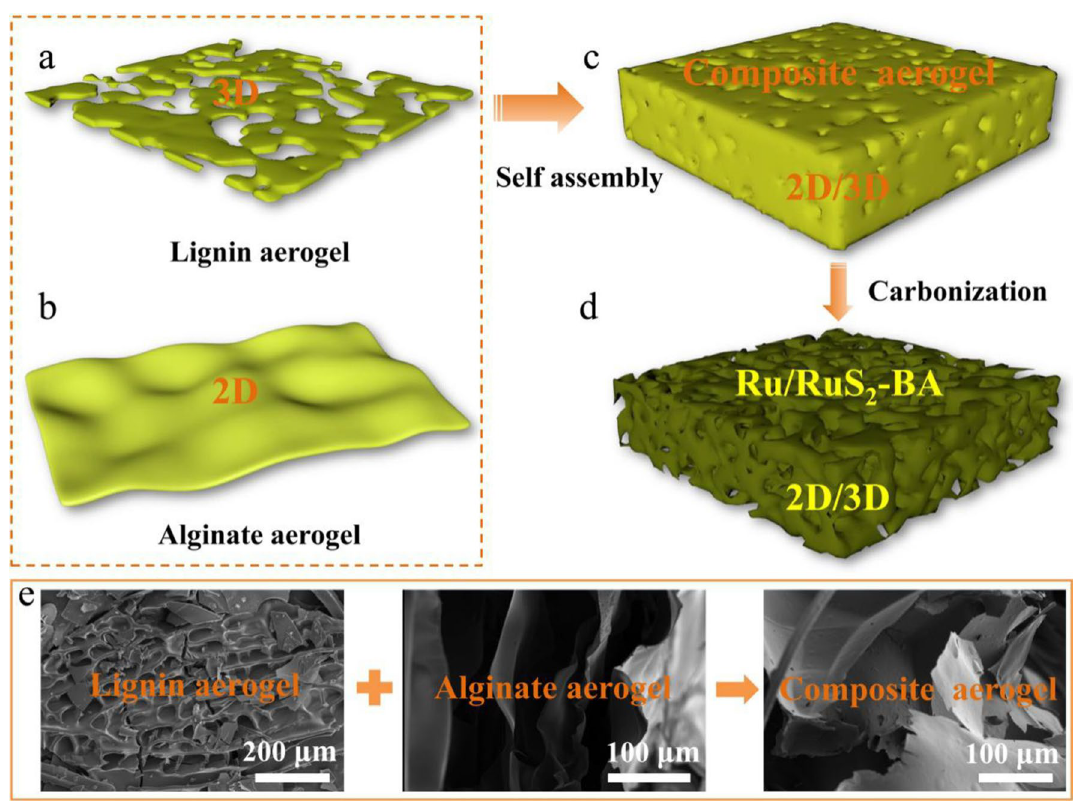
Fig. 6 Schematic illustration for structural design mechanism of Ru/ RuS 2 -BA. a Lignin aerogel with 3D structure, b alginate aerogel with 2D structure, c polymer aerogel with 2D/3D structure (alginate aero- gel + lignin aerogel), and d carbon aerogel with 2D/3D structure that